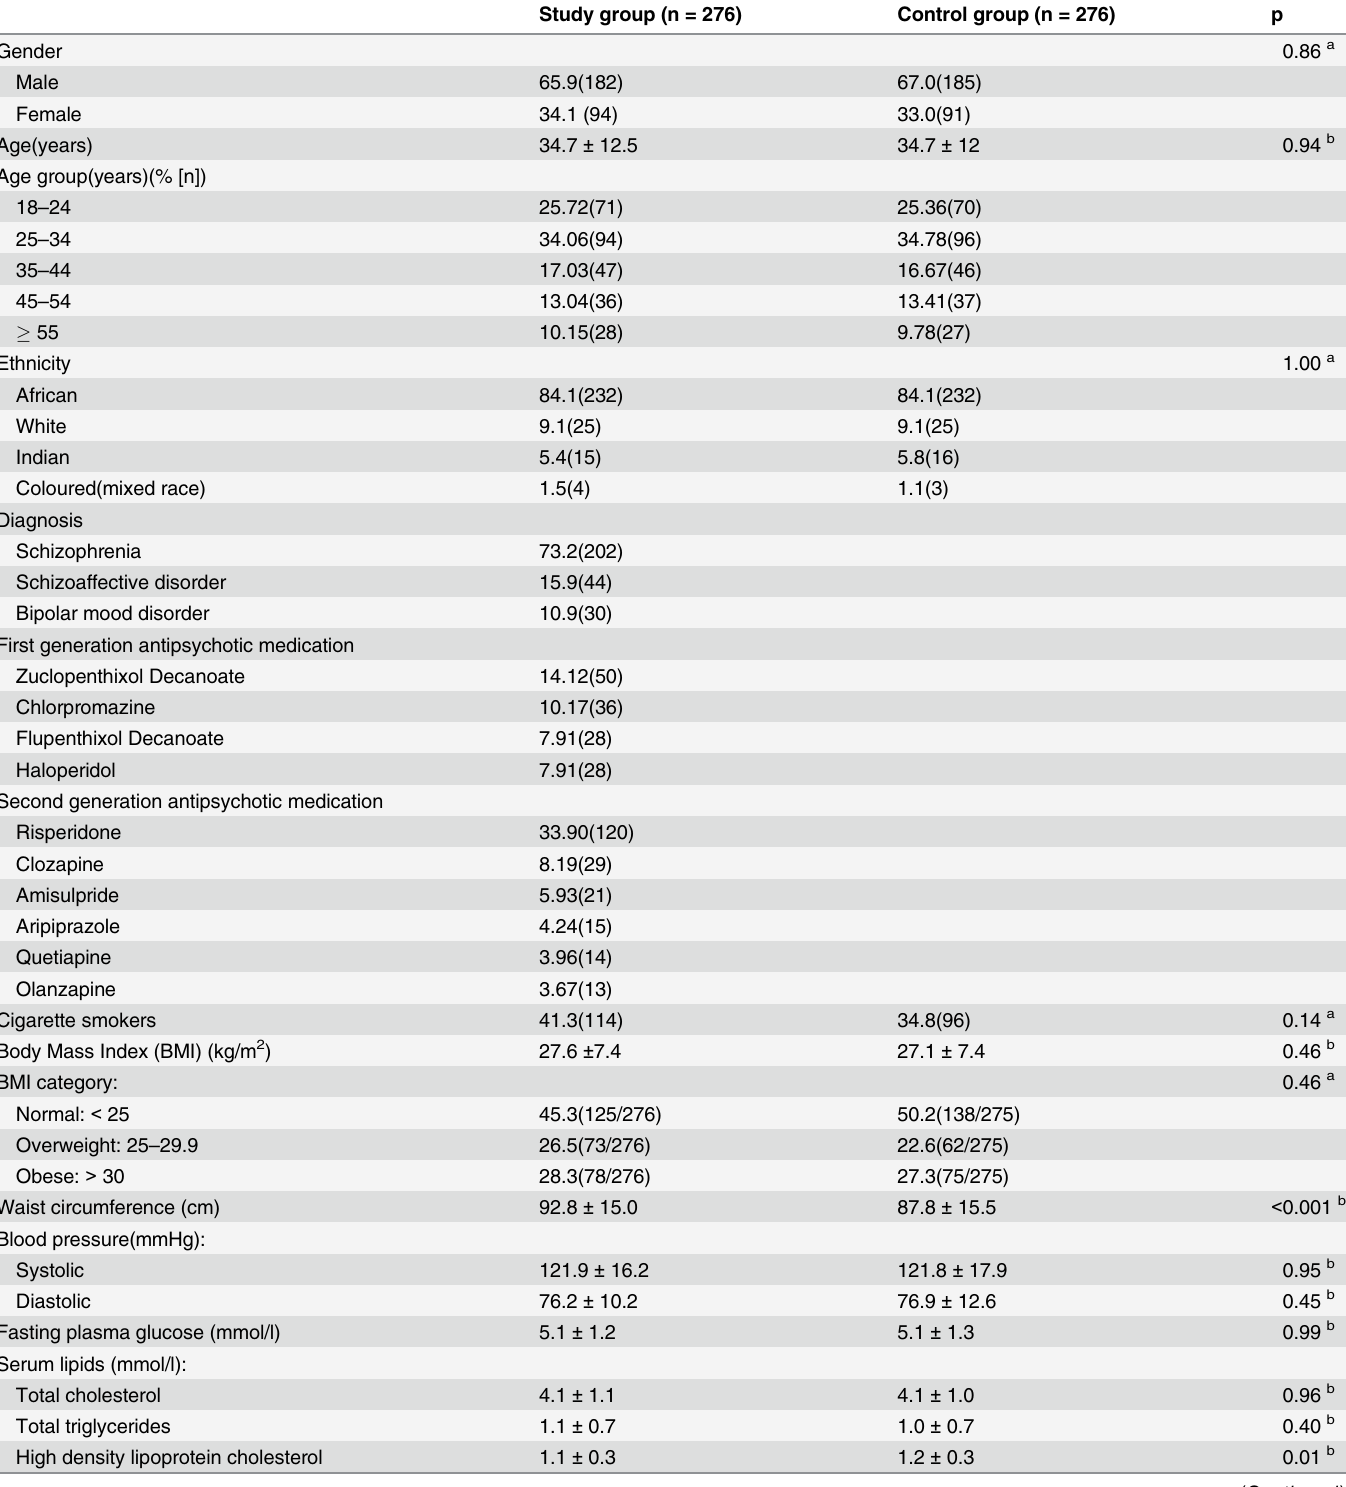
Table 1. Clinical and laboratory characteristics of patients with severe mental illness (study group) and control